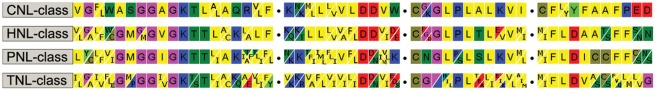
Conserved motifs of the NBS domains of the four classes of NBS-encoding genes.The four motifs are separated by dots and are in the following order: P-loop, kinase 2, GLPL and RNBS-D.